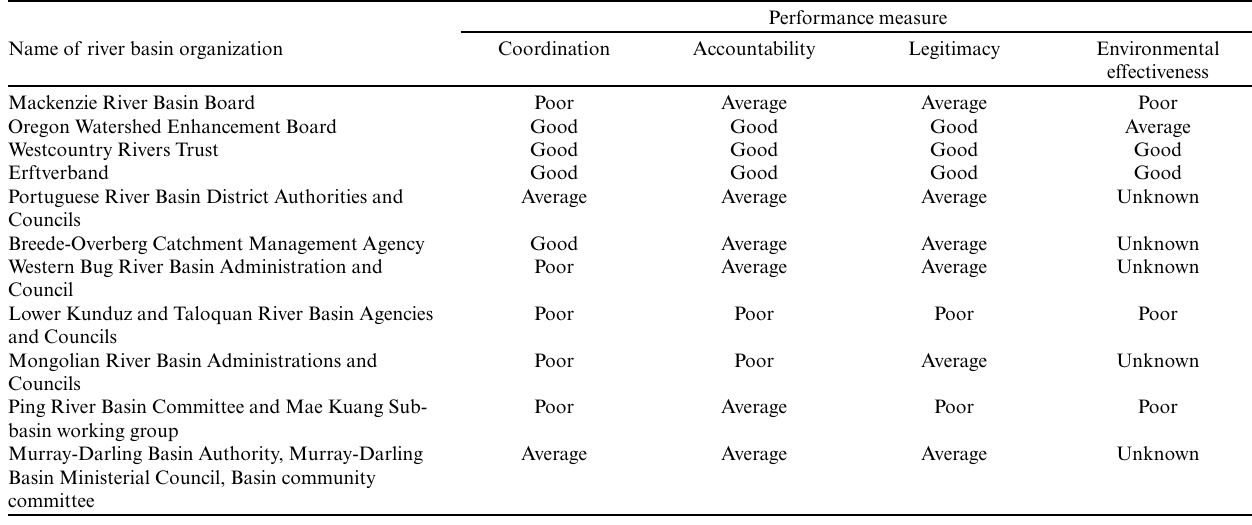
Table 4. Findings on the performance of the river basin organizations. A rank of “unknown” indicates that no data were